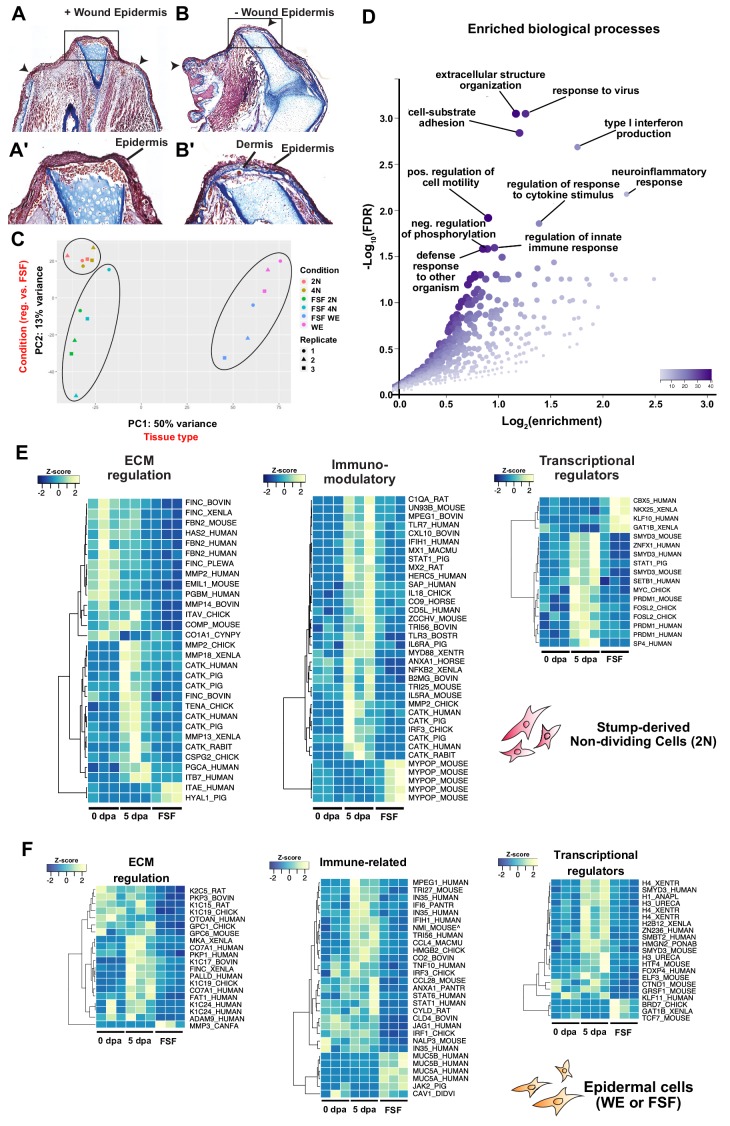
Sequencing of full skin flap sutured limbs reveals global dysregulation of ECM regulation, inflammation, and tissue histolysis.(A–B’) Representative picro-mallory stained sections of normal regenerating and full skin flap sutured limbs. Full skin flap sutured limbs contain the extra dermal layer of skin tissue. Arrowheads demarcate the amputation plane. (C) Principal component analysis (PCA) of sequenced samples (5 dpa 2N, 5 dpa 4N, 5 dpa WE, FSF 2N, FSF 4N, FSF WE) based on the top 500 most highly expressed genes reveals separation along PC1 by tissue type and PC2 by condition. (D) Plot of enriched GO biological processes from all differentially expressed transcripts in non-dividing cells in full skin flap sutured limbs. (E) Heatmaps of normalized transcripts per million (TPM) values of annotated differentially expressed transcripts involved in ECM regulation, inflammation, or transcriptional regulation in non-dividing cells within regenerating stump tissues. (F) Heatmap of normalized TPM levels of annotated differentially expressed transcripts that are ECM regulators, immunomodulators, and transcriptional regulators in epithelial cells of full skin flap sutured limbs. dpa, days post-amputation, WE, wound epidermis, FSF, full skin flap, FDR, false discovery rate; ECM, extracellular matrix.